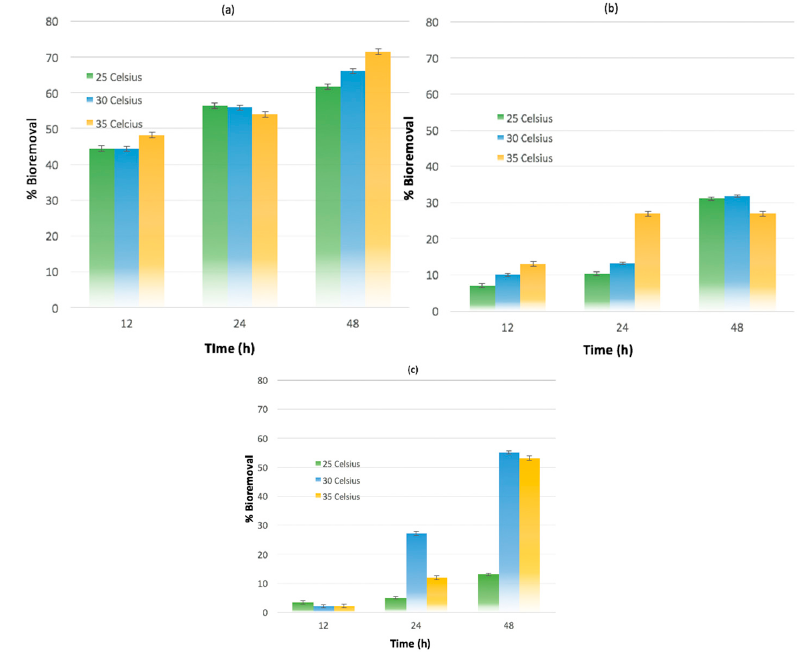
Figure 1. Removal percentages of MB with initial concentration of ( a ) 50 parts per million (ppm); ( b ) 100 ppm; ( c ) 200 ppm by exposition to yeast G. geotrichum KL20A at three different temperatures during the 48 h.